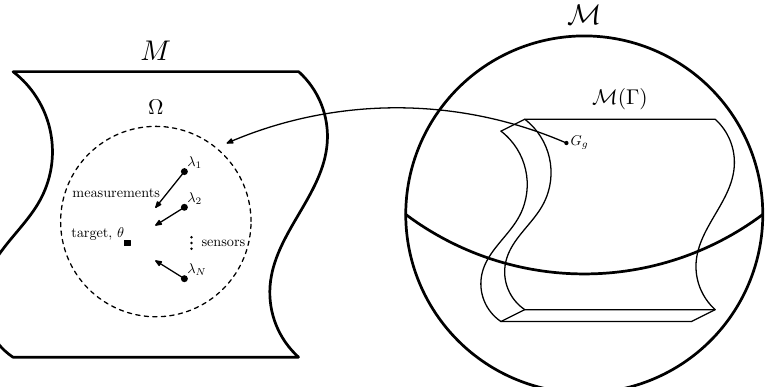
Figure 1. Diagrammatic representation of the sensor model; sensors are at λ i ∈ M taking measure- ments of a target at θ ∈ M . A measure of distance between different sensor configurations, physically corresponding to change in information content is obtained through a suitable restriction of the metric G g (13) to the configuration manifold M ( Γ ) ⊂ M , the space of all Riemannian metric on M . M is almost certainly not topologically spherical, it is merely drawn here as such for